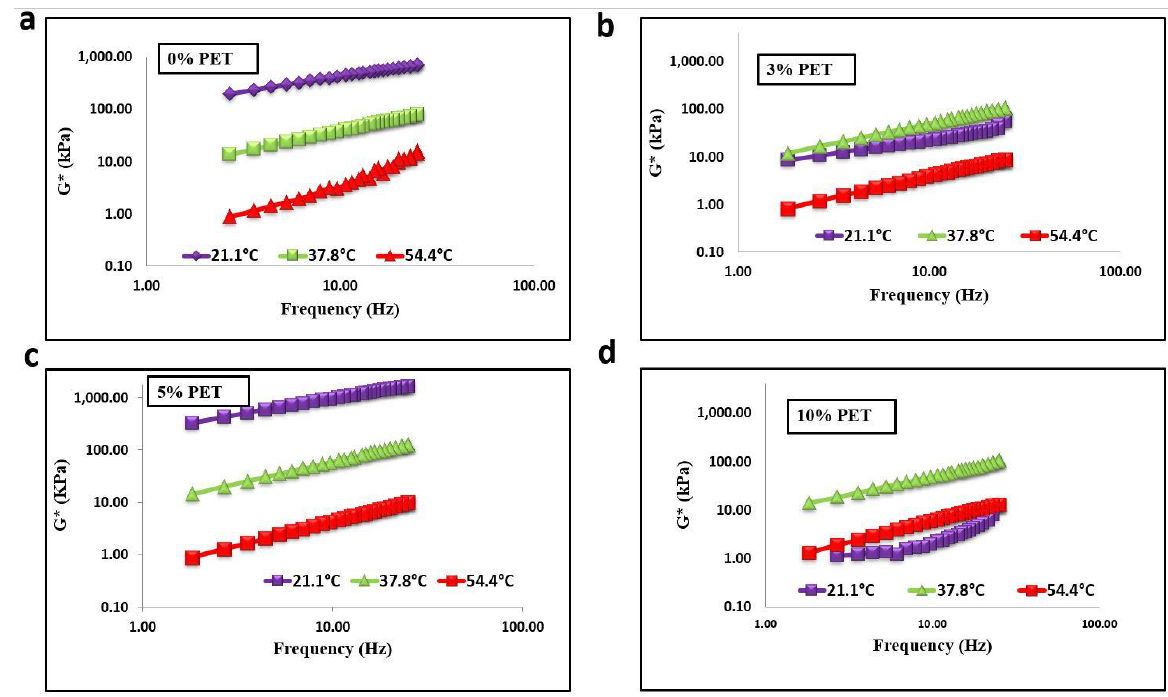
Figure 8. Isothermal plots of RTFO-aged binder with PET content of ( a ) 0%, ( b ) 3%, ( c ) 5%, and ( d ) 10%.